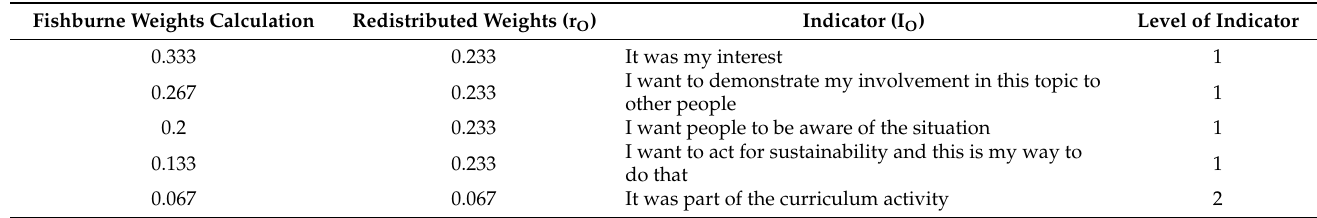
Table 30. Reasoning indicators for